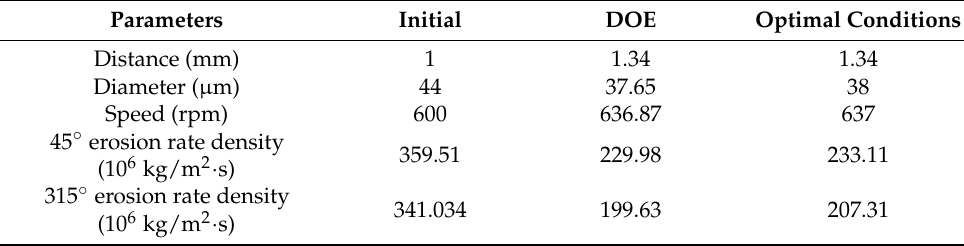
Figure 11. Optimization conditions. Table 5. Optimization